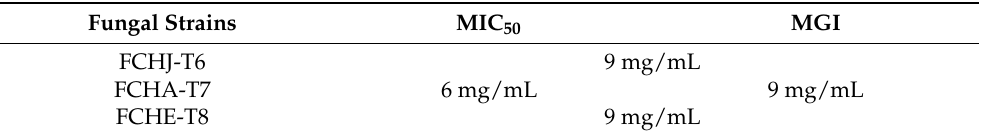
MIC 50 : minimum concentration of essential oil that inhibited 50% of radial growth and MGI: concentration of essential oil that caused maximum inhibition of radial